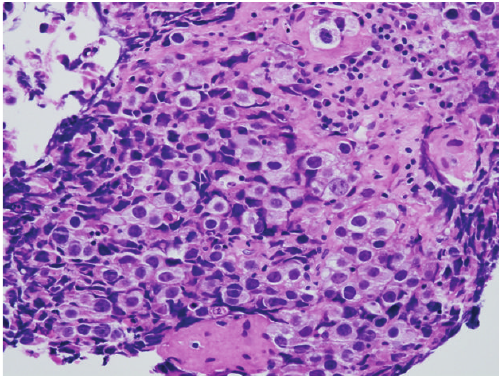
Figure 2: Two-cell pattern of germ cell tumors (hematoxylin and eosin